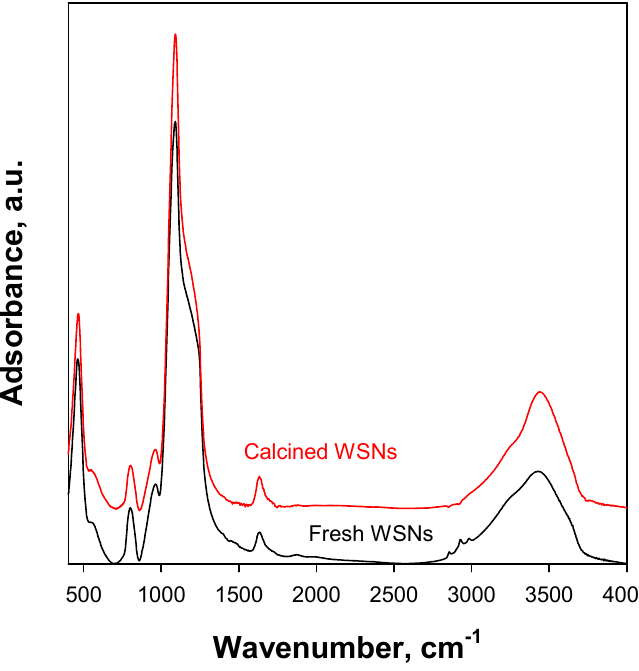
Figure 2. FT-IR spectra of WSNs before and after calcination at 450 °C.